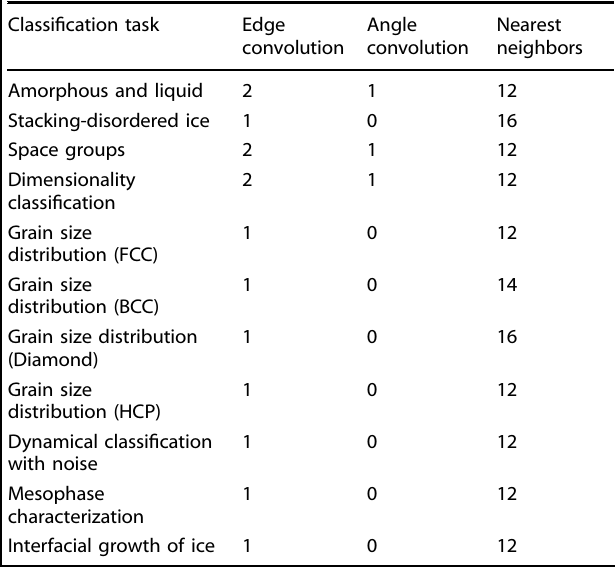
Table 1. CEGANN Network hyperparameters used during different classi fi cation